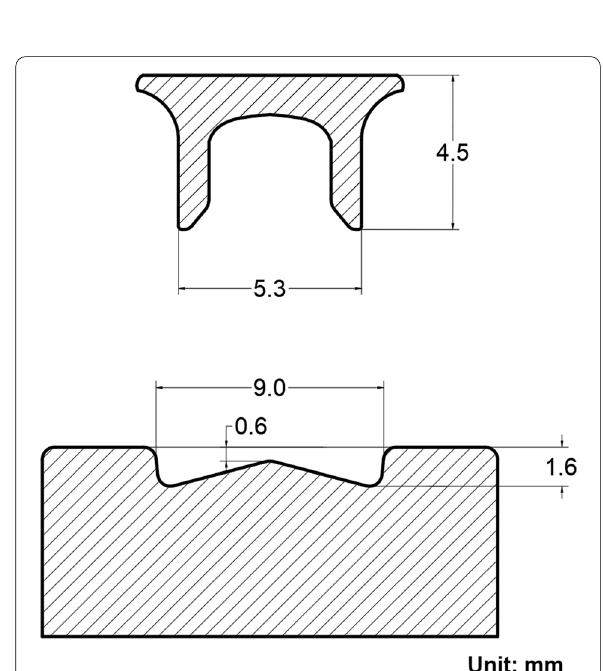
Figure 1 Cross-sectional geometries of rivet and